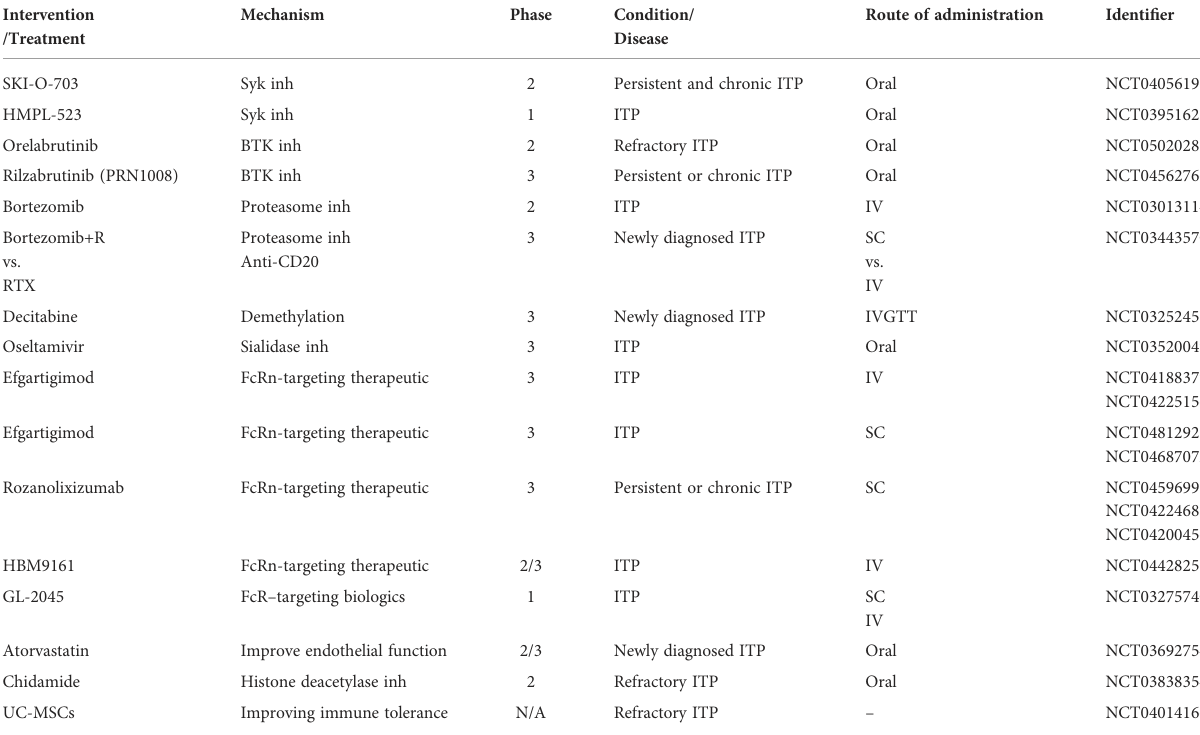
TABLE 2 Ongoing clinical trials of new drugs for refractory ITP.